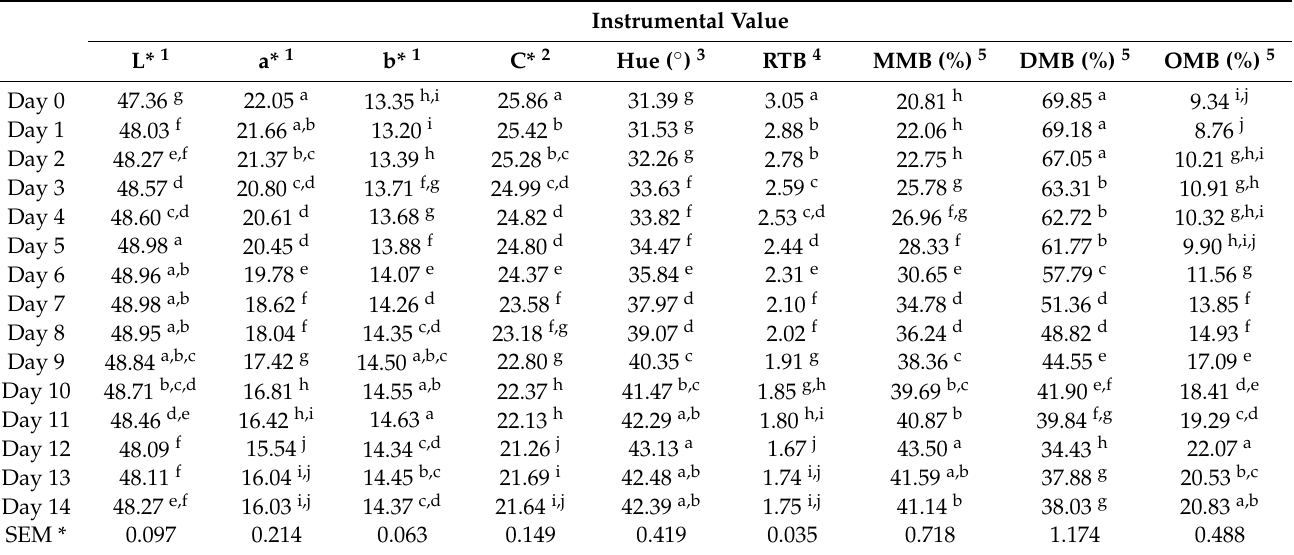
Table 2. Influence of retail display (d) on color values of vacuum-packaged ground beef. Instrumental